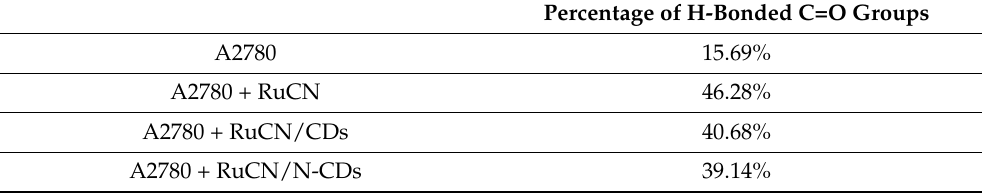
Table 4. Percentages of carbonyl groups (C=O) containing hydrogen bonds in untreated and treated A2780 cells. The percentages are calculated on the basis of spectra given in Figure